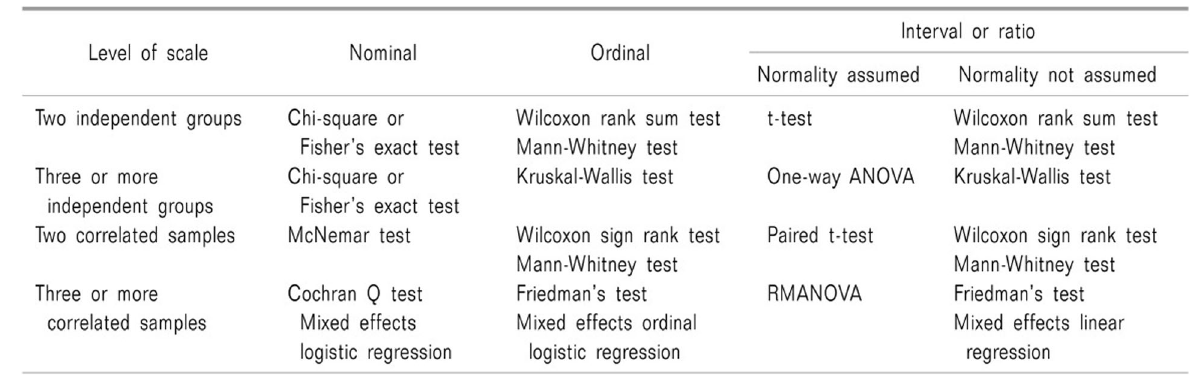
Table 1 The statistical tests that could be used based on the type of data, i.e. nominal or ordinal, distribution of data and number of groups for comparison (reproduced after permission from the Editor in Chief of the Korean Journal of Pain and is from